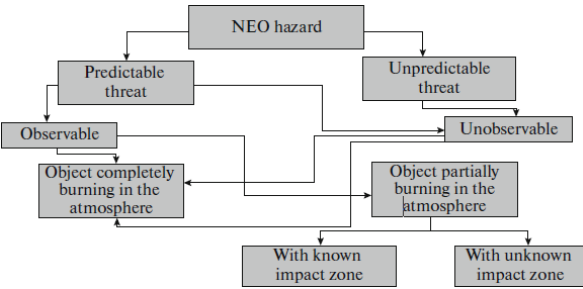
Figure 5. Basic classification of NEO hazard (Pavlova et al. 2021).